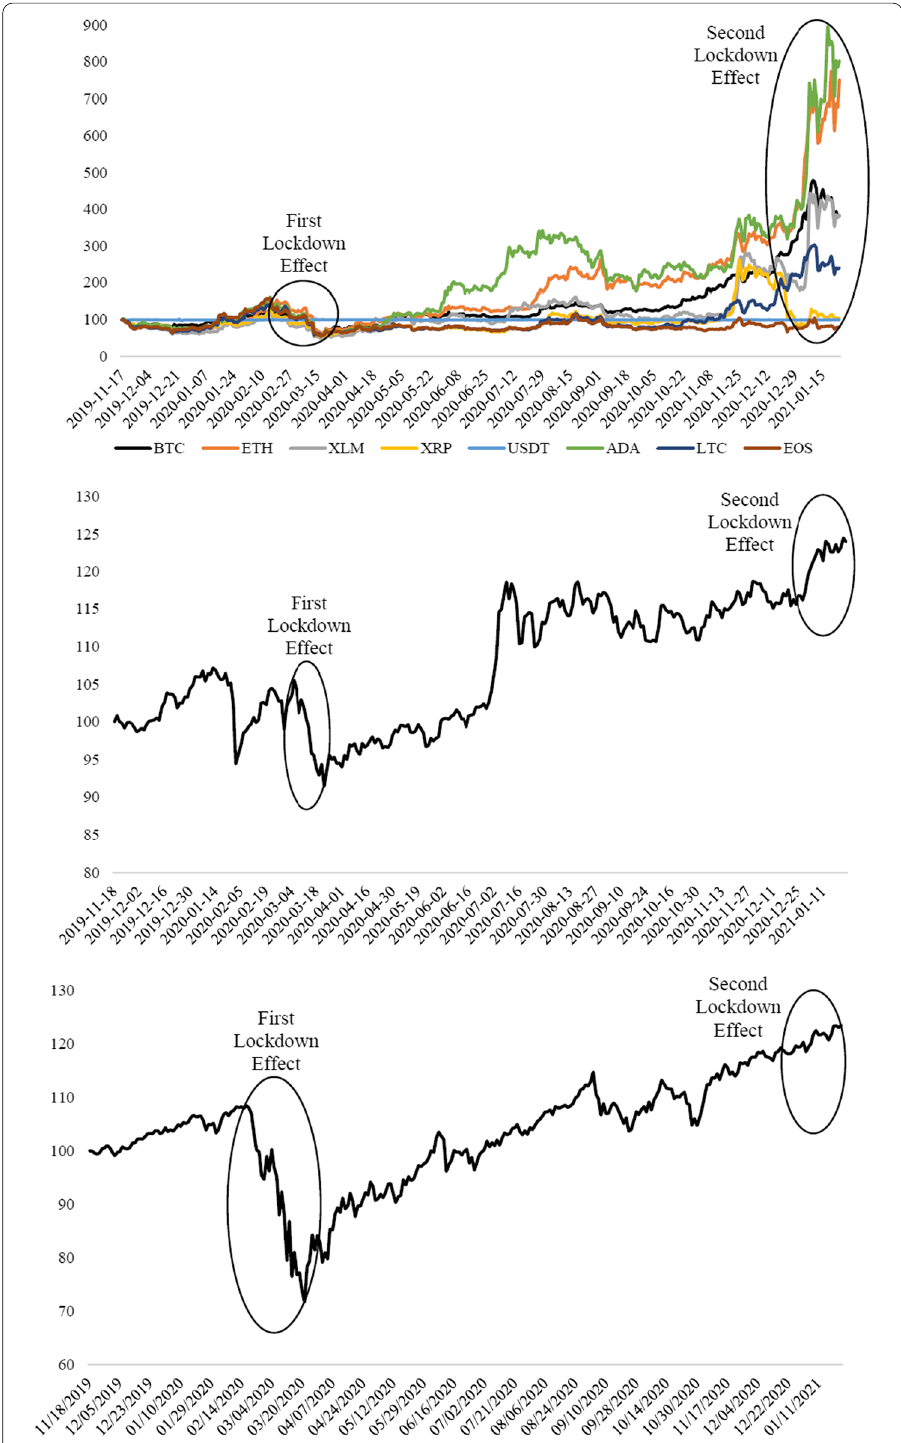
Fig. 12 Price changes in Shanghai Stock Exchange, S&P 500, and the Selected Cryptocurrencies. Note: Both the Shanghai Composite Index, S&P 500 Index, and the selected digital currency price series are standardized to a starting price of 100. The Shanghai Composite Index and S&P 500 Index are extracted from Yahoo Finance and Nasdaq,